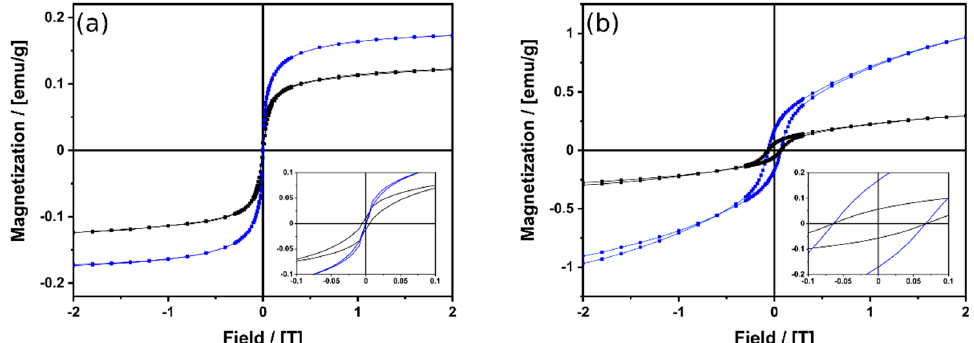
Figure 5. SQUID measurement at ( a ) 300 K and ( b ) 4 K on a mechanically separated sample at sides with high (blue curve) and low (black curve) magnetite concentrations, with respective inlets showing the hysteresis region.